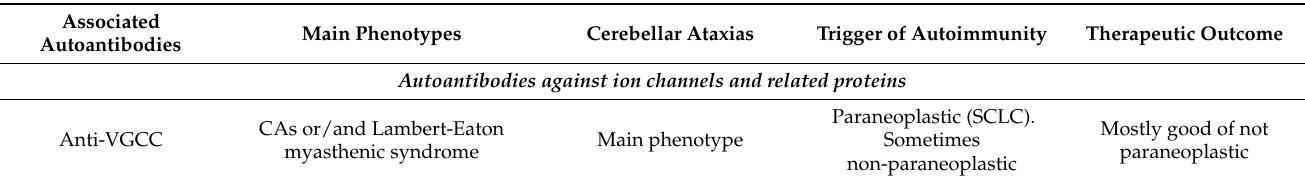
Table 2. Clinical features of cerebellar ataxia associated with autoantibodies against ion channels and related proteins, synaptic adhesion/organizing molecules, and transmitter